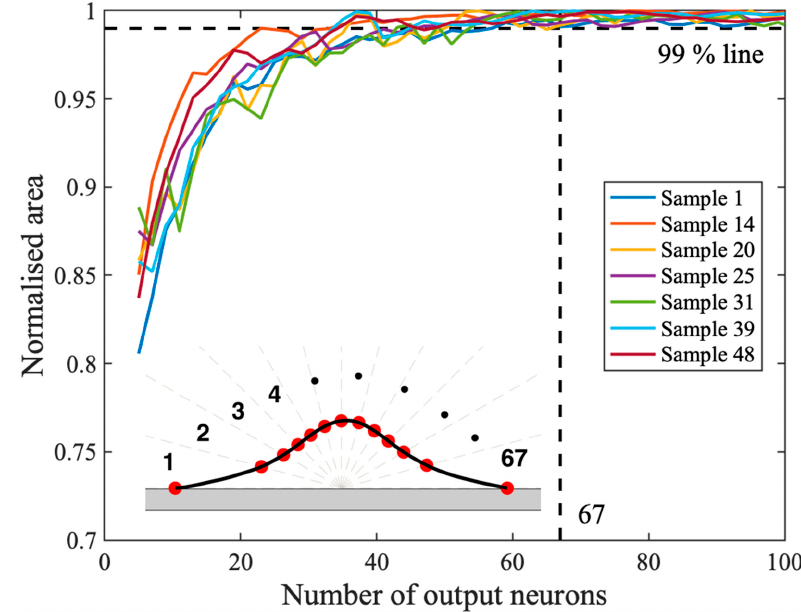
Table 2. Summary of the performance evaluation results of the developed model in Figure 3 in terms of Mean Absolute Error (MAE), Maximum Absolute Error (MXAE), Mean Absolute Percent Error (MAPE), and Maximum Absolute Percent Error (MXAPE).